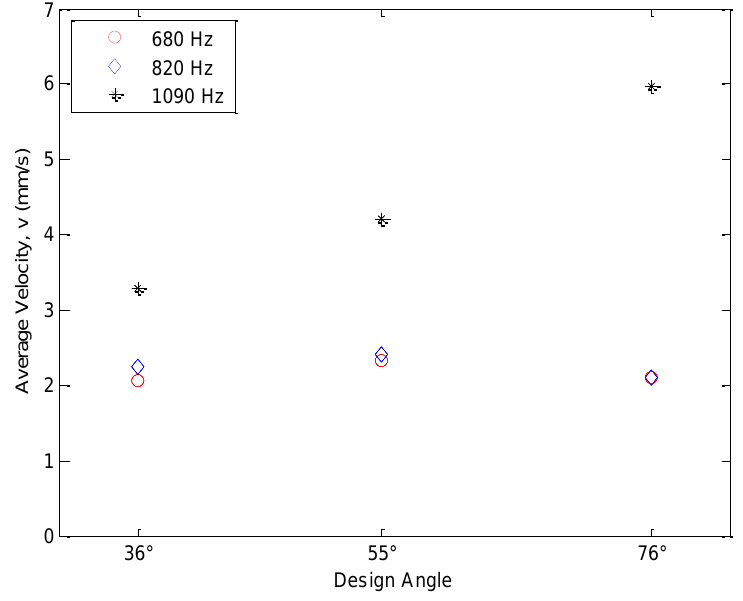
Figure 14. Results showing the dependence of robot velocity on front leg angle.